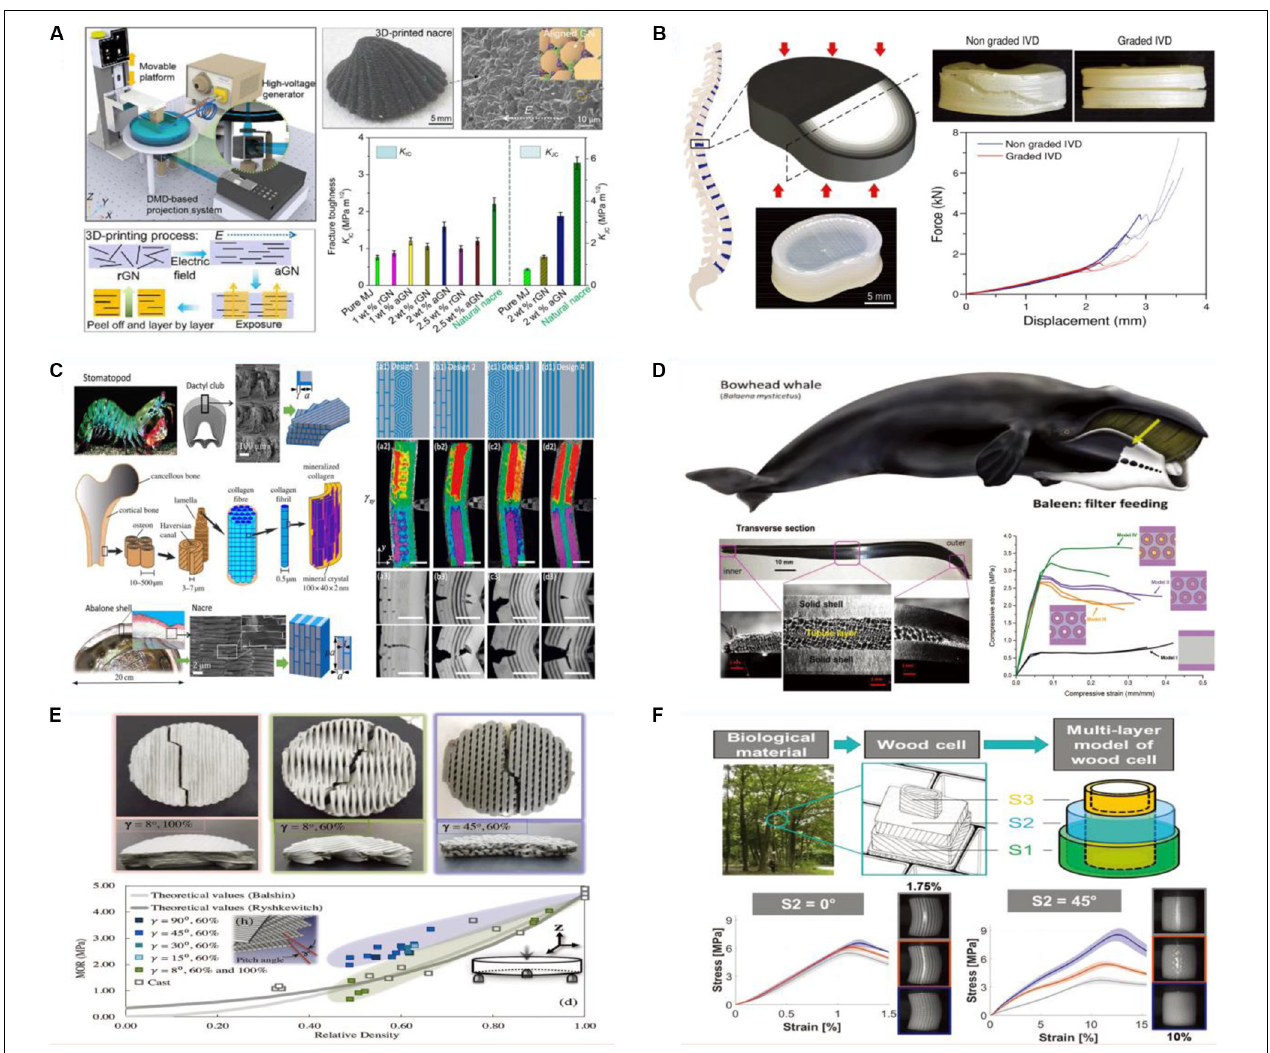
FIGURE 2 | (A) The electrically assisted 3D printing of a nacre-inspired hierarchical structure with different mass ratios of GNs (Yang et al., 2019). Reproduced with the permission of the American Association for the Advancement of Science. (B) Graded inter-vertebral disc (IVD) and non-graded IVD, inspired by the human IVD after compression tests (Kokkinis et al., 2018). Reproduced with the permission of 2018 WILEY-VCH Verlag GmbH & Co. KGaA, Weinheim. (C) The controllable crack locations and crack patterns of hybrid biomimetic hierarchical structures, inspired by the microstructure of stomatopod, bone, and abalone shell (Jia et al., 2018). Reproduced with the permission of Elsevier Ltd. (D) Hierarchical structure models inspired by baleen (Wang et al., 2018). Reproduced with the permission of 2018 WILEY-VCH Verlag GmbH & Co. KGaA, Weinheim. (E) Cement-based material disks, based on Bouligand architectures (Moini et al., 2018). Reproduced with the permission of 2018 WILEY-VCH Verlag GmbH & Co. KGaA, Weinheim. (F) A three-layer cylindrical structure, inspired by wood (Zorzetto and Ruffoni, 2019). Reproduced with the permission of 2018 WILEY-VCH Verlag GmbH & Co. KGaA,